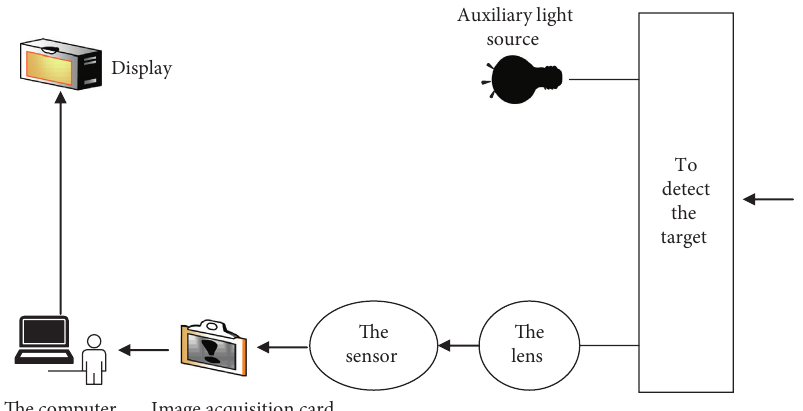
Figure 3: Principle flow chart of visual sensing technology.